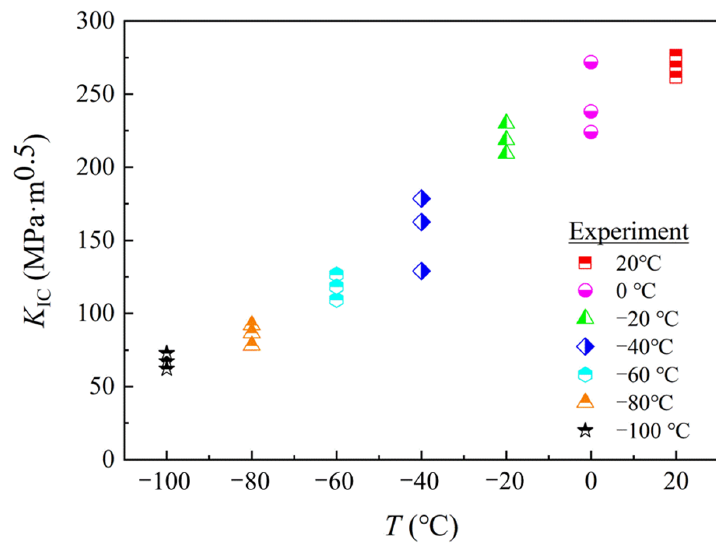
Figure 10. Test results. Figure 10. Test